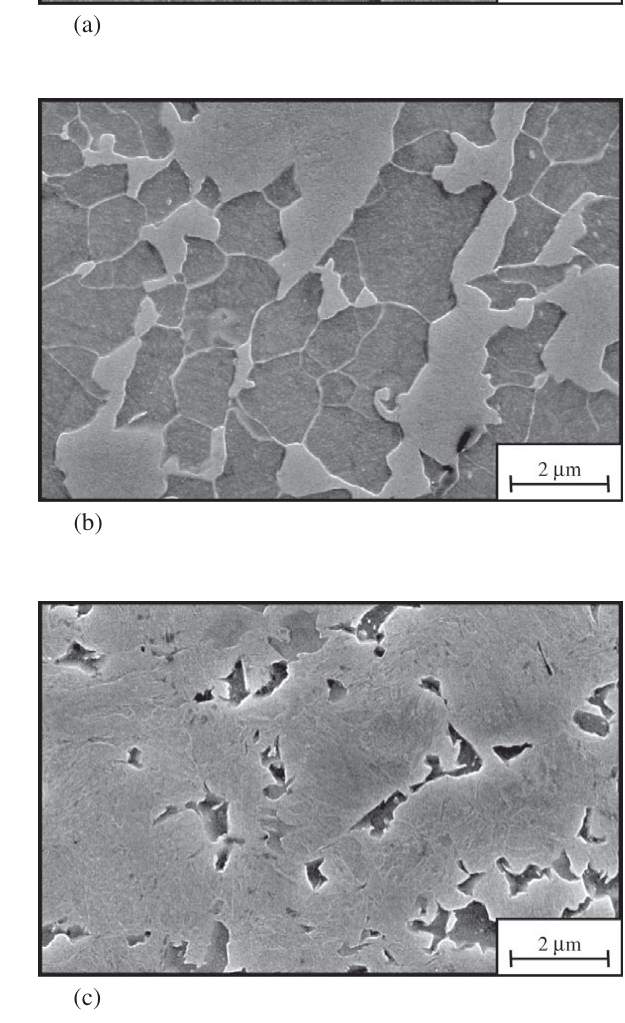
Figure 8. Microstructural evolution during the transformation of ferrite into austenite for samples deformed at 750 °C after a 3 min holding time. a) Sample strained to ε = 0.5; b) Sample strained to ε = 0.85; c) Sample strained to ε =